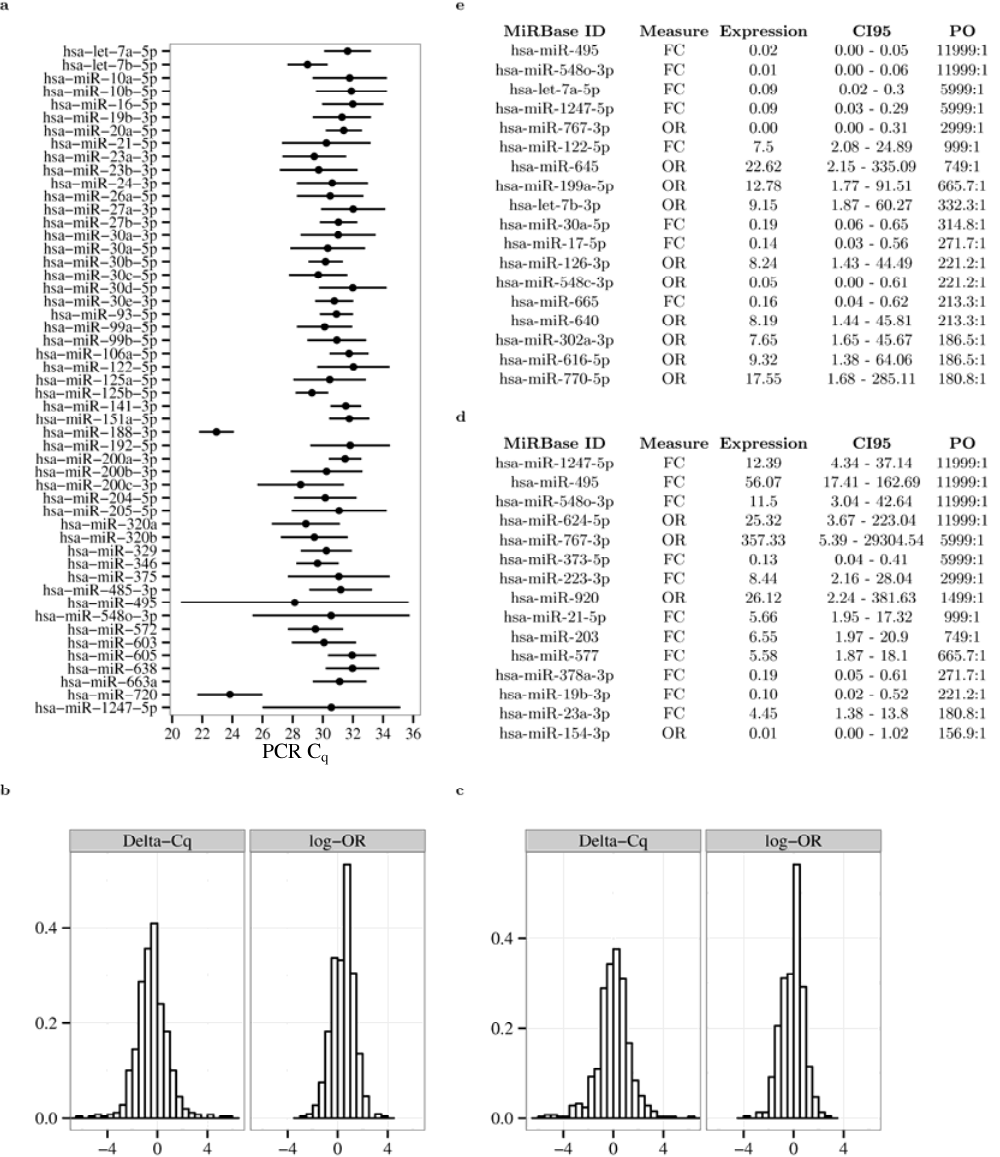
Figure 1. Expression levels of microRNAs in the urine of patients with Type 1 diabetes and associations between subsequent development of microalbuminuria and gender. ( a ) microRNAs with the highest (top 10%) expression (mean ± 1 standard deviation) in the urine of patients who never develop nephropathy; ( b ) histograms of the Delta C q and empirical log odds ratios of detection between the microalbuminuric and normal groups; ( c ) histograms of the Delta Cq and empirical log odds ratios of detection between men and women; ( d ) differences in expression in women versus men; ( e ) differences in expression level between MA (microalbuminuric) and N (normal) group. In ( d , e ), expression changes (Expression) are given either as fold changes (FC), or odds ratios (OR) of exceeding the detection limit and associated 95% credible interval (CI95). Expression values greater than one and less than one indicate overexpression and underexpression, respectively. PO: posterior odds of the hypothesis that a given microRNA exhibits concentration changes are in the direction indicated by the expression value vs. the opposite direction. C q : qPCR quantification cycle (threshold crossing)